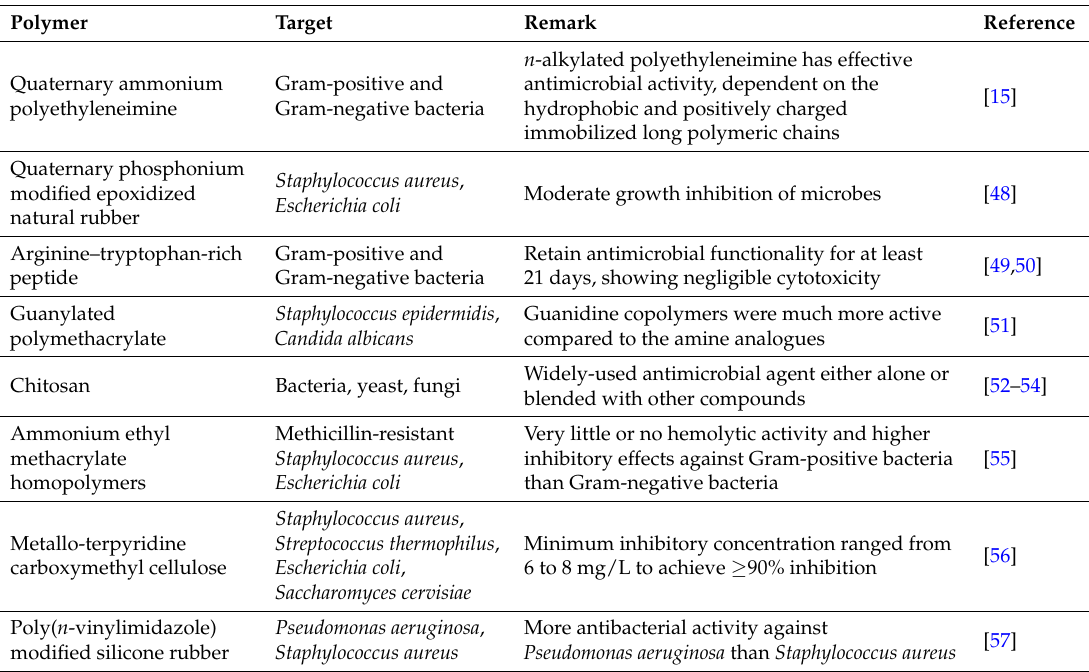
Table 5. Examples of biocidal polymers for antimicrobial